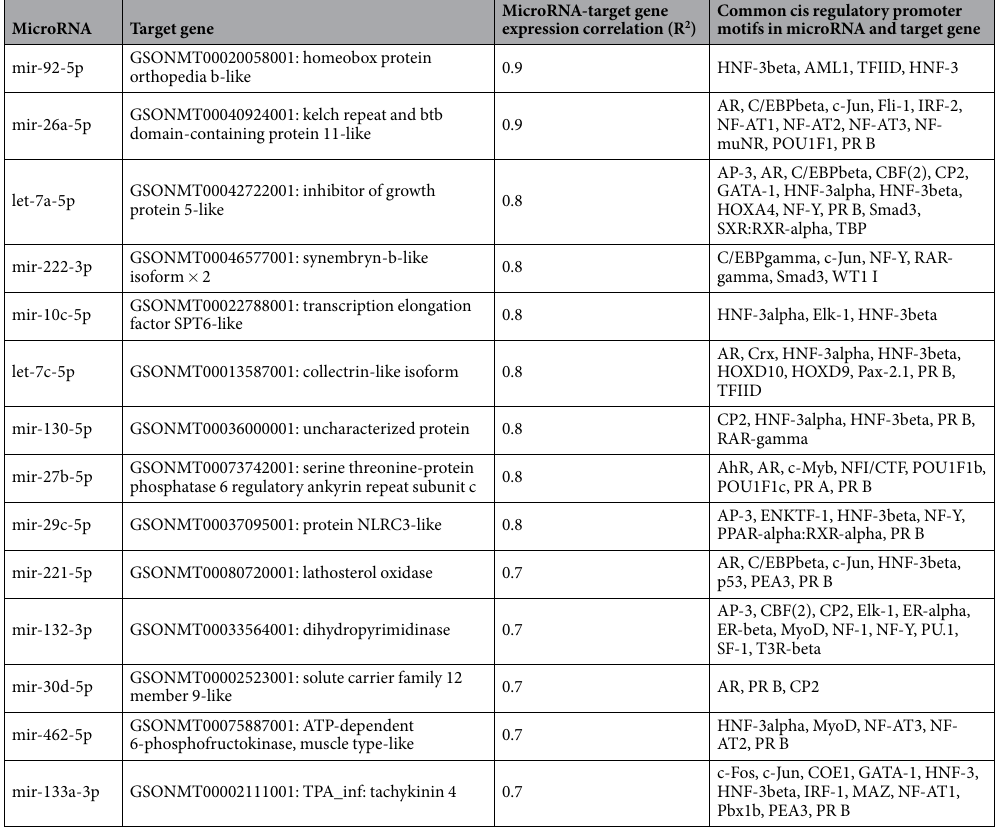
Muscle Shear force. A total of 56 microRNAs were DE between high and low shear force groups, of them 46 microRNA were downregulated and 10 microRNAs were upregulated in fish with high shear force (Fig. 2 and Supplementary Dataset 1C). Correlation between expression level and variation in muscle shear force was studied for 10 DE microRNAs in 90 fish, of them, 5 microRNAs (mir-126-3p, mir-148-3p * , mir-20-5p, mir-206 and mir- 133a-5p) explained 6.5% to 9.0% variation in muscle shear force depending on the microRNA (FDR-p < 0.05) (Table 3). To the best of our knowledge, association of microRNAs with muscle firmness has not been previously reported in salmonids. The connective tissue proteins, especially collagen, play an important role in determining muscle shear force. Density of collagen fibers in connective tissue determines fish muscle firmness 36 . Interestingly, out of 56 DE microRNA, 31 microRNAs targeted 49 genes coding for collagen proteins or regulators of collagen biosynthesis, metabolism or structure (Supplementary Dataset 2, see name and GO terms of target genes). In addition, 31 DE microRNAs targeted at least 61 genes coding for extracellular matrix proteins and their regulators other than collagens and collagen regulators (Supplementary Dataset 2, see GO terms of target genes). It has been observed that abundance of collagen and connective tissue in extracellular matrix determines stiffness and gaping in fish muscle 37 . These DE microRNAs, which target collagens and other extracellular matrix connective tissues and their regulators, may be used to develop suitable genetic markers to improve muscle firmness in rainbow trout. Muscle whiteness index. Seventy-seven microRNAs were DE, 58 upregulated and 19 downregulated, in fish families with high muscle whiteness index compared to low whiteness index families (Fig. 2 and Supplementary Dataset 1C). From DE microRNA, correlation between microRNA expression level and variation in phenotype was performed for 11 microRNAs, of them, variation in expression level of 6 microRNAs significantly corre- lated with variation in muscle whiteness index (Table 3). Expression of mir-20-5p, mir-148-3p * and mir-206 explained 8.8%, 8.7% and 8.4% of the variation in muscle whiteness respectively. Gene enrichment analysis of DE microRNA targets revealed that 30 biological pathways were significantly overrepresented which included transcription, transcription regulation, multicellular organism development, protein ubiquitination and Wnt signaling (Supplementary Dataset 4). We observed that most of the DE microRNA in response to variation in muscle yield, crude fat content and shear force were also DE in response to variation in muscle whiteness. These data suggest that muscle whiteness may be, at least partially, impacted by the mechanisms that regulate the other three muscle quality traits. Muscle color parameters correlate to muscle fat content in Atlantic salmon 38 . Perhaps